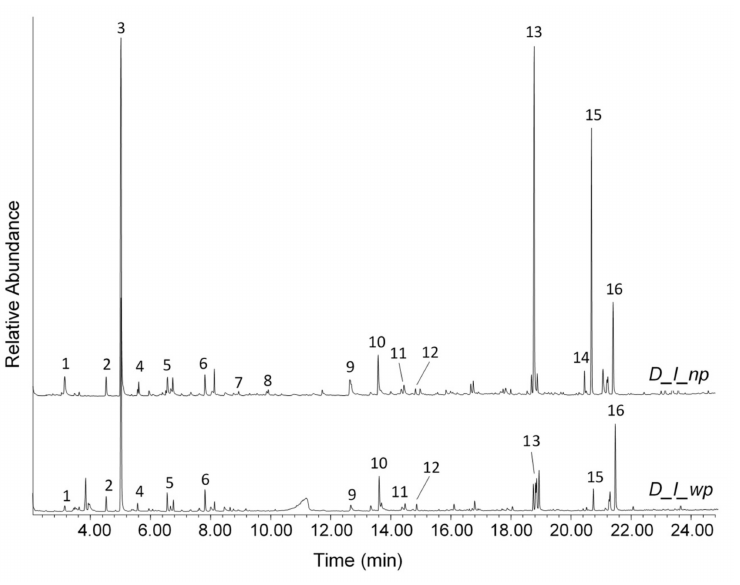
Figure 13. Py-GC / MS curves of samples D_I_np and D_I_wp showing characteristic markers of the lower styrene-acrylic paint layer and residues of the upper alkyd spray. Toluene (1); ethylbenzene (2); styrene (3); (1-methylethyl)-benzene (4); α -methylstyrene (5); (1-methylenepropyl)-benzene